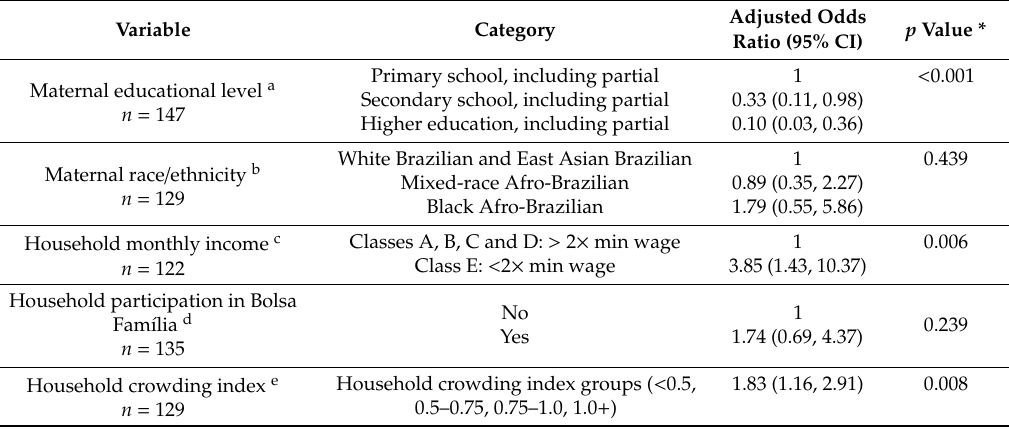
Table 3. Multivariate associations of socioeconomic indicators with microcephaly